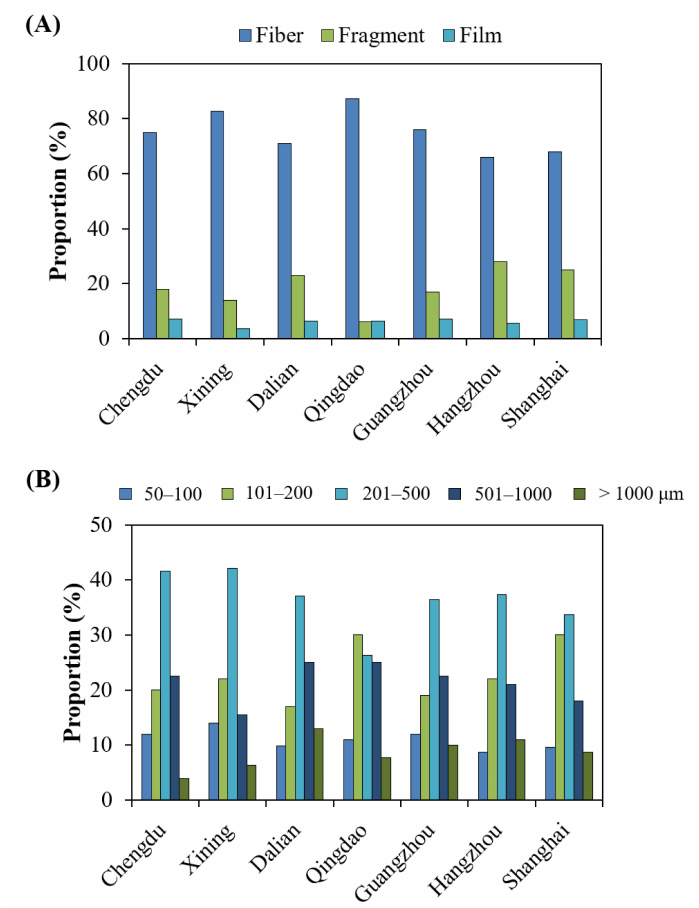
Figure 2. Percentage (%) of different ( A ) shapes and ( B ) sizes of MPs in takeout food containers collected from different Chinese